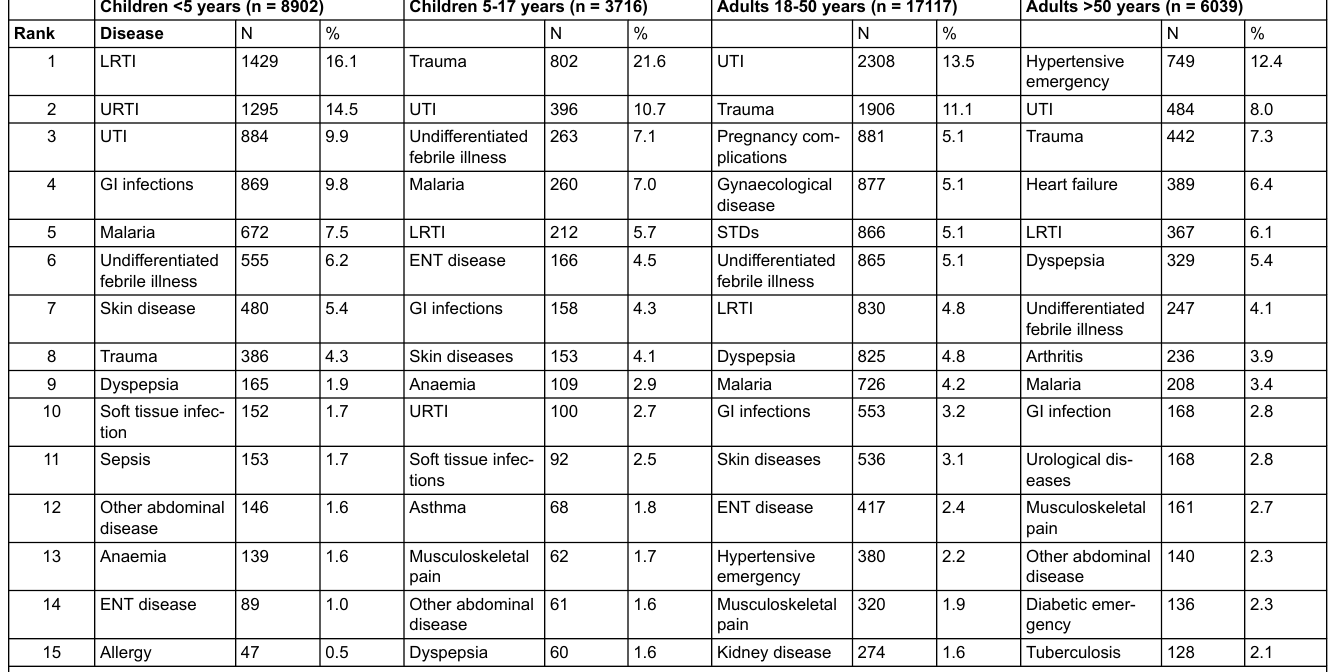
LRTI: lower respiratory tract infection; URTI: upper respiratory tract infection; UTI: urinary tract infection; GI-infection: gastroenteritis and other intestinal infections; STDs: sexu- ally transmitted diseases; ENT-diseases: ear-nose-throat